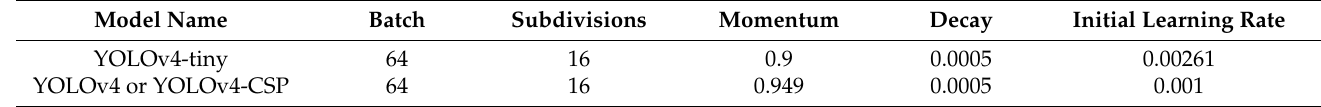
Table A2. Hyperparameters of the YOLOv4 models.